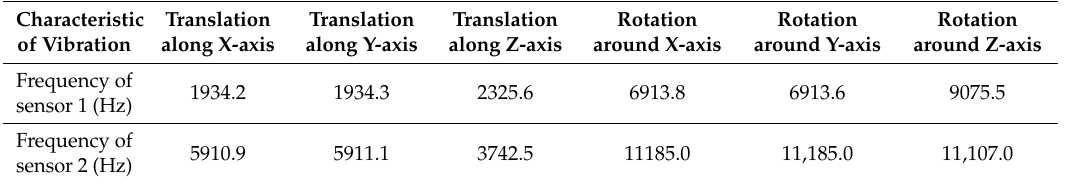
Table 6. First six orders natural frequencies and the modes of